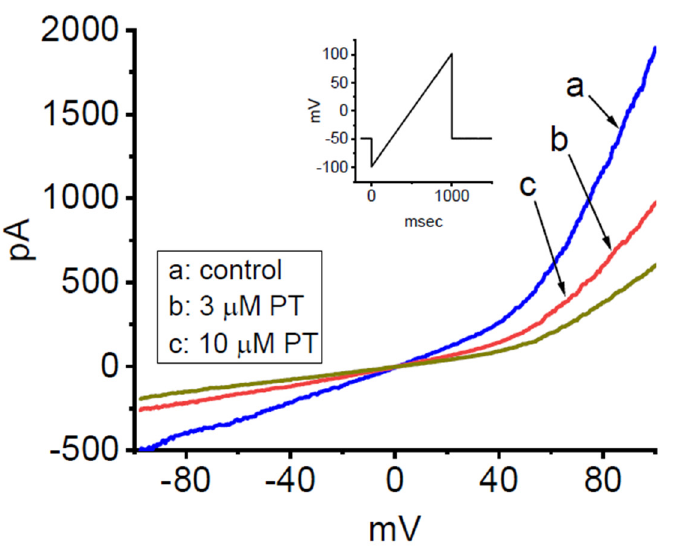
Figure 9. Inhibitory effect of PT-2385 on I K(DR) recorded from human 13-06-MG glioma cells. In these experiments, we kept cells to be bathed in high-K + , Ca 2+ -free solution and filled up the recording pipet by using a K + -enriched solution. The examined cell was voltage-clamped at − 50 mV, and an upsloping ramp pulse from − 100 to +100 mV for a duration of 1 s was then applied to evoke I K(DR) . Inset shows the voltage protocol applied. ( a ) control (i.e., PT-2385 was not present); ( b ) 3 µ M PT-2385; and ( c ) 10 µ M PT-2385.